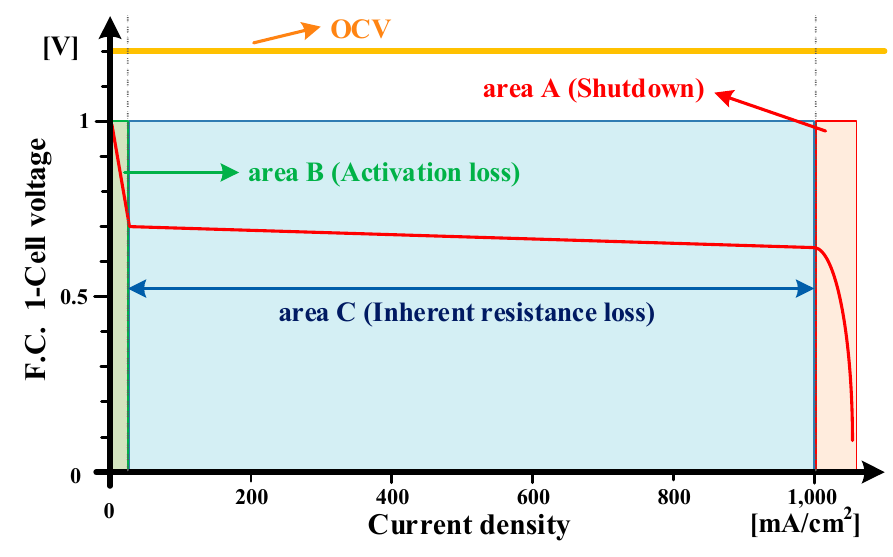
Figure 2. Voltage characteristic curve of fuel cell.